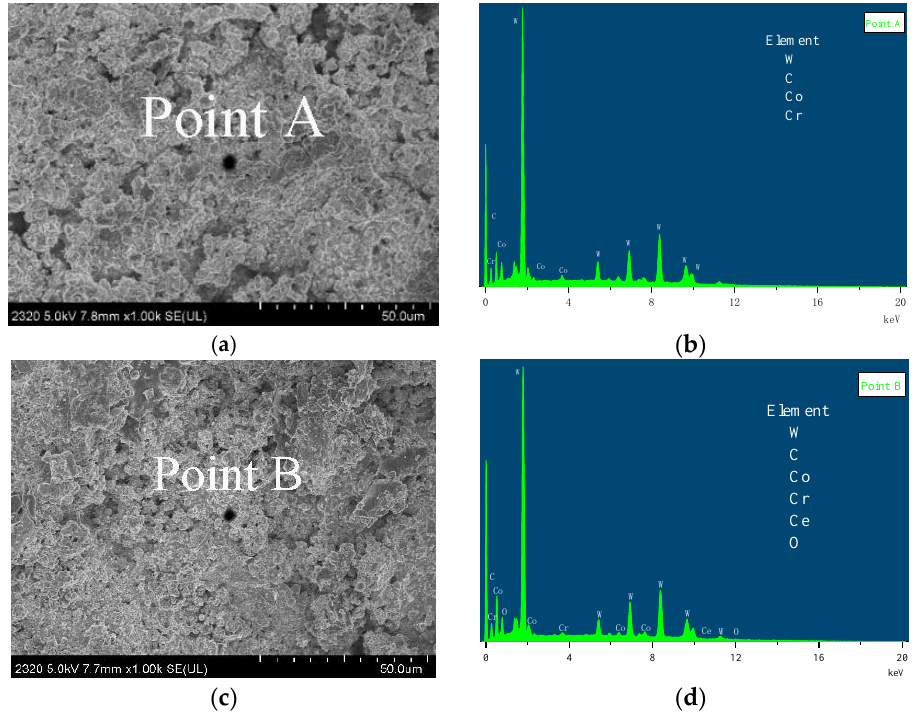
Figure 6. Energy spectrum analysis of point A and B. ( a ) point A of WC-10Co-4Cr coating; ( b ) energy spectrum analysis of point A; ( c ) point B of WC-10Co-4Cr+CeO 2 coating; ( d ) energy spectrum analysis of point B.